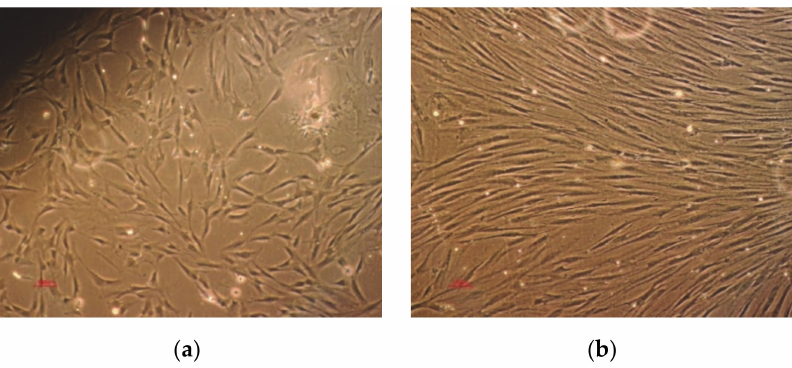
Figure 4. Differentiated osteoblasts: ( a ) second passage and ( b ) at confluency. A cell population containing ~6 × 10 4 osteoblasts were seeded on each testing sub- strate. This number of cells has been considered the most appropriate for the type of materials involved in the present research and was selected according to the output of a previous study